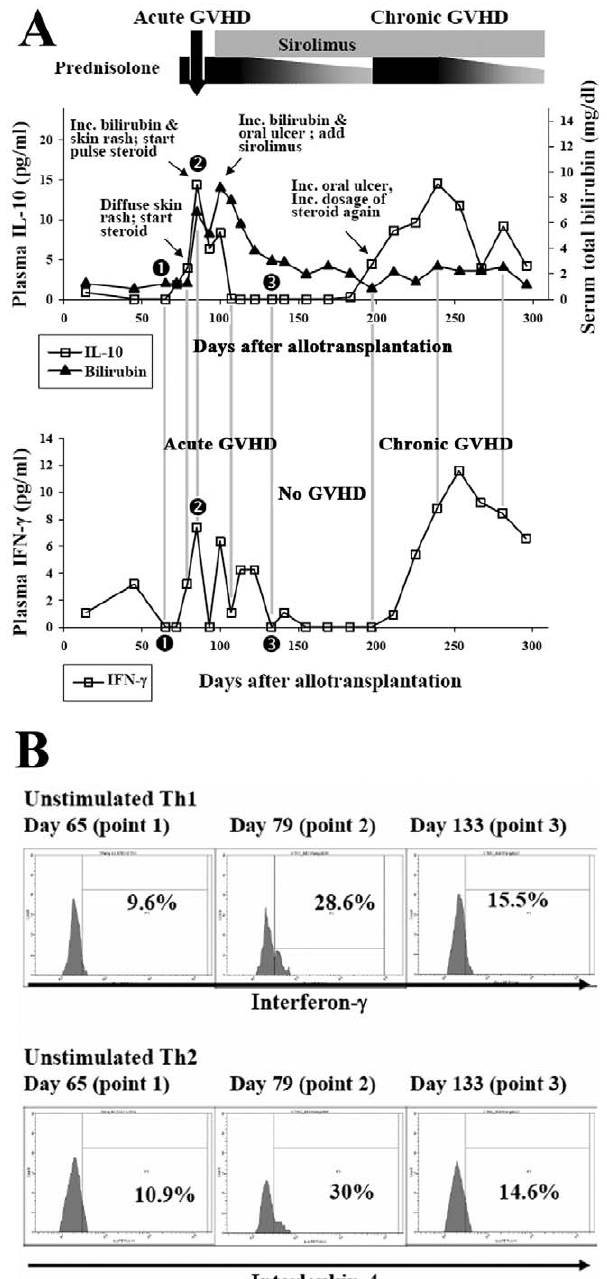
Figure 2. A patient with acute and chronic GVHD (Patient No. 10). Good correlation between plasma IL-10, IFN- c levels (figure 2A), the frequency of uTh1, uTh2 (figure 2B) and clinical course of a patient having acute and chronic GVHD. Big arrow on the top of Figure 2A indicates pulse prednisolone therapy. Label 1, 2, and 3 on figure 2A (as well as in other figures) indicate the time points for which the frequencies of uTh1 and uTh2 within total CD4 + T cell population were examined and the results were showed as histogram in figure 2B.